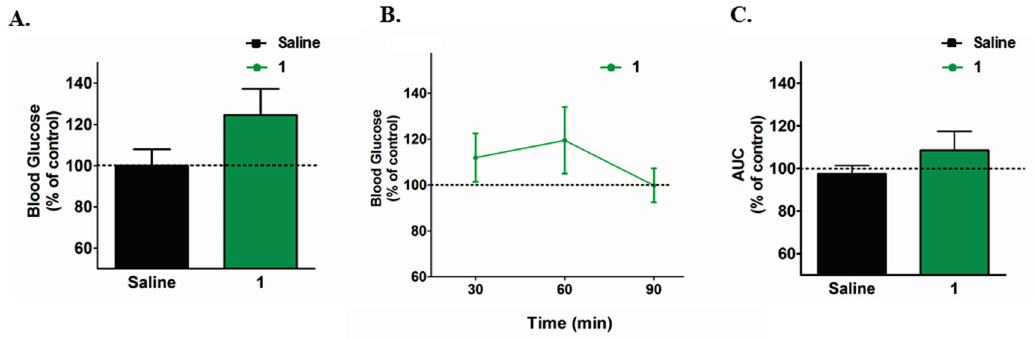
Figure 4. ( A ) Effect of 1 on fasting glycemia of chronically treated diabetic mice expressed as percentage of saline treated group; and ( B ) effect of a single intraperitoneal dose of 1 (3.0 mg/kg) on the blood glucose levels and ( C ) area under the blood glucose response curve (AUC) of lean treated mice expressed as percentage of lean saline treated group (mean ±